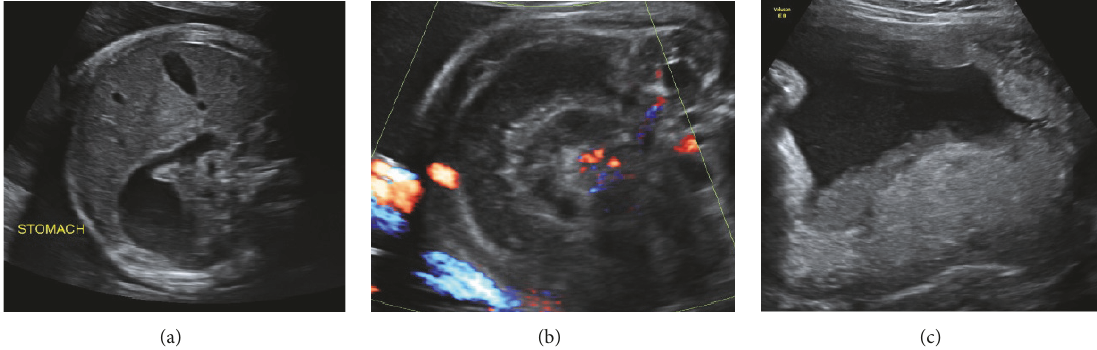
Figure 1: Ultrasound images of the key antenatal findings: (a) dilated appearing stomach with relatively normal duodenal diameter, not consistent with duodenal atresia; (b) concentric small bowel visible around the twisted mesenteric pedicle (whirlpool sign) and the superior mesenteric vein malpositioned on the left of the artery; and (c) dense sediment noted in the amniotic fluid, which was noted to be bile at the time of